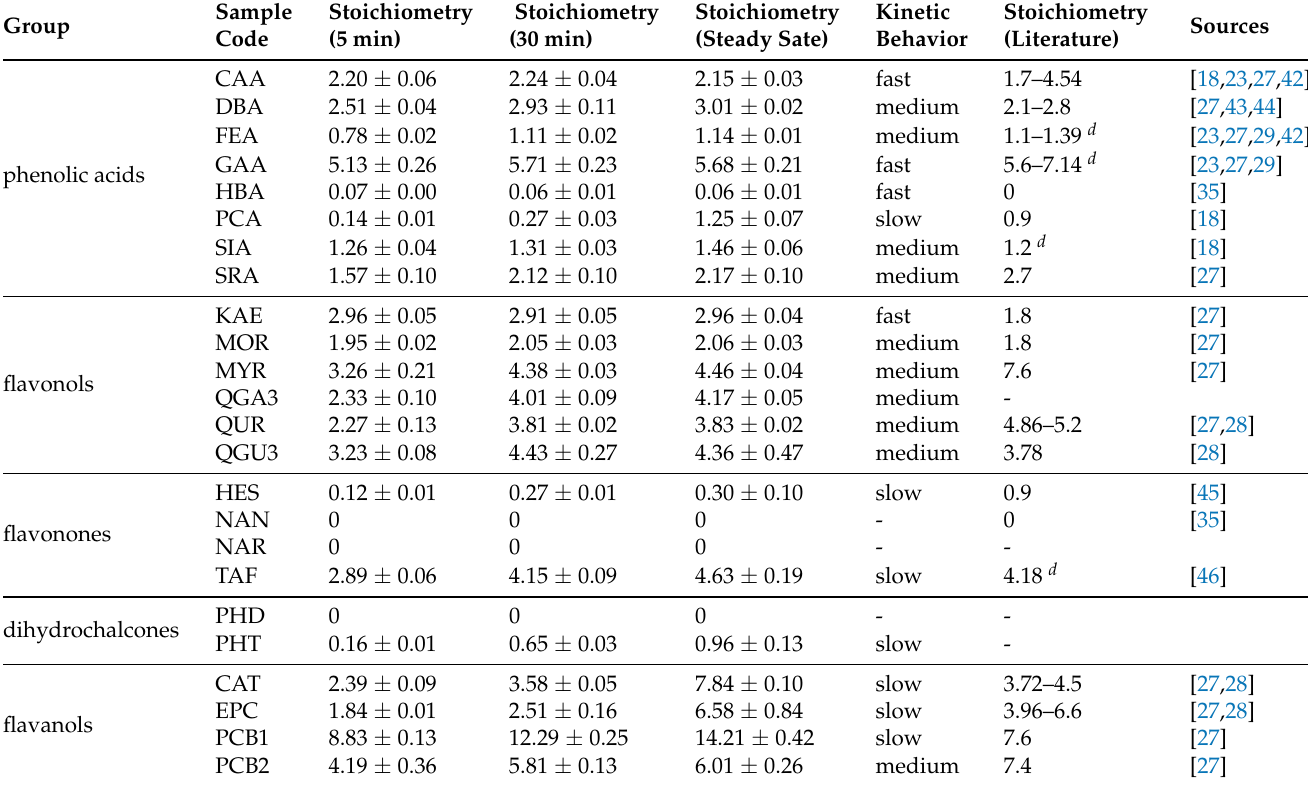
Table 2. Results of the DPPH assay presented as stoichiometry values after 5 and 30min and stationary final values with literature comparisons and kinetic behaviors. Data are mean values of three measurements and standard errors. Sample names and structures are shown in Table